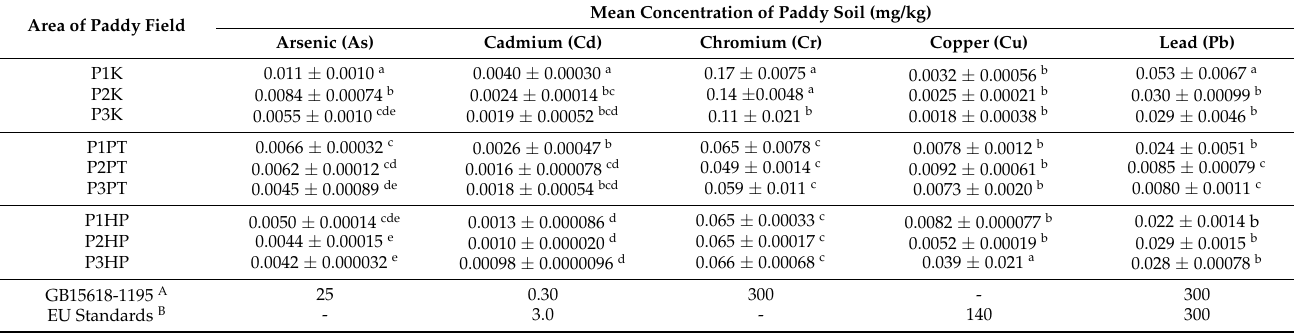
Table 5. Concentration of heavy metals in paddy soil collected from all sampling